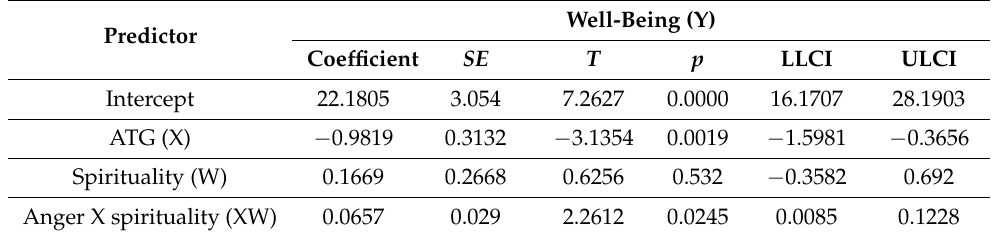
Table 3. Moderation analysis: Anger, spirituality, and